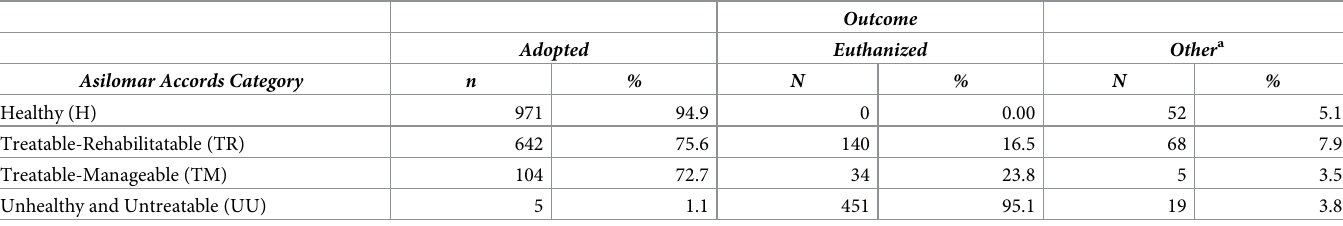
Table 5. Outcomes by Asilomar accord category (N = 2,487).